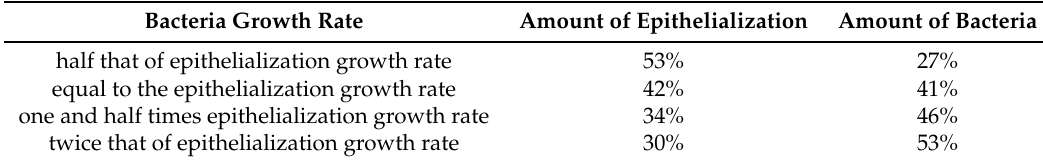
Table 1. Epithelialization and infection for stalled wounds. Bacteria Growth